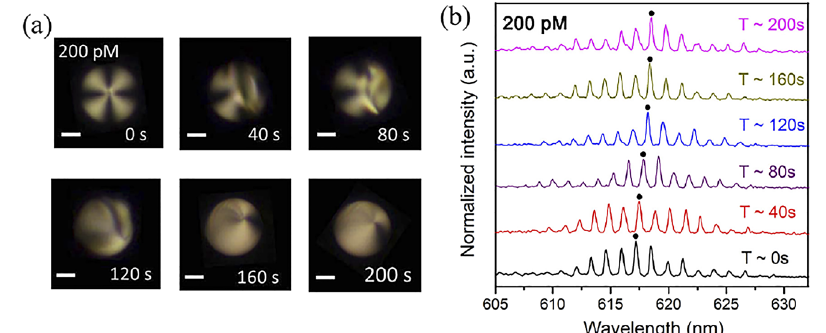
Figure 28: (a) Evolution of the POM images of stearic acid-doped 5CB microdroplets incu- batedwith200pMcopper(II)chlorideinPBS solution (pH = 8.5). Scale bar = 20 μ m. (b) Lasing spectra of stearic acid-doped 5CB microdroplet incubated with 200 pM cop- per(II) chloride in PBS solution (pH = 8.5) as a function of time. Black dots indicate the position of the WGM selected to monitor the spectral shifting of the droplet lasing emis- sion